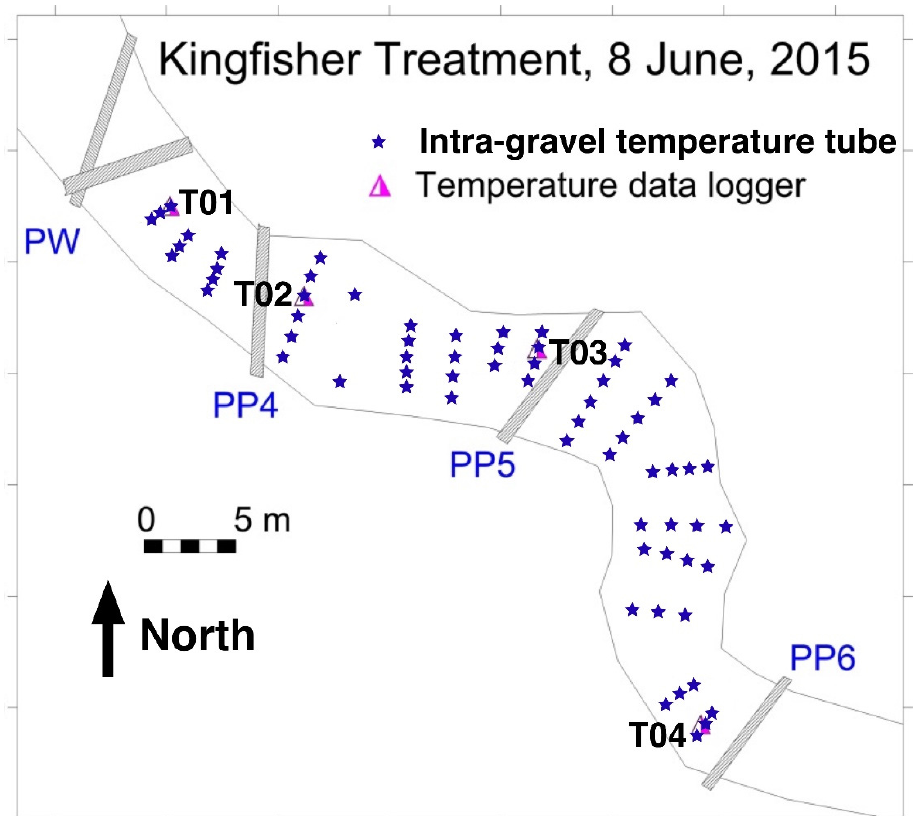
Figure 8. Locations of intra-gravel temperature measurement tubes and the four surface water temperature data loggers, T01–T04. PP4–6 are sill logs for plunge-pool structures No. 4–6, and PW is a pocket-water log structure.